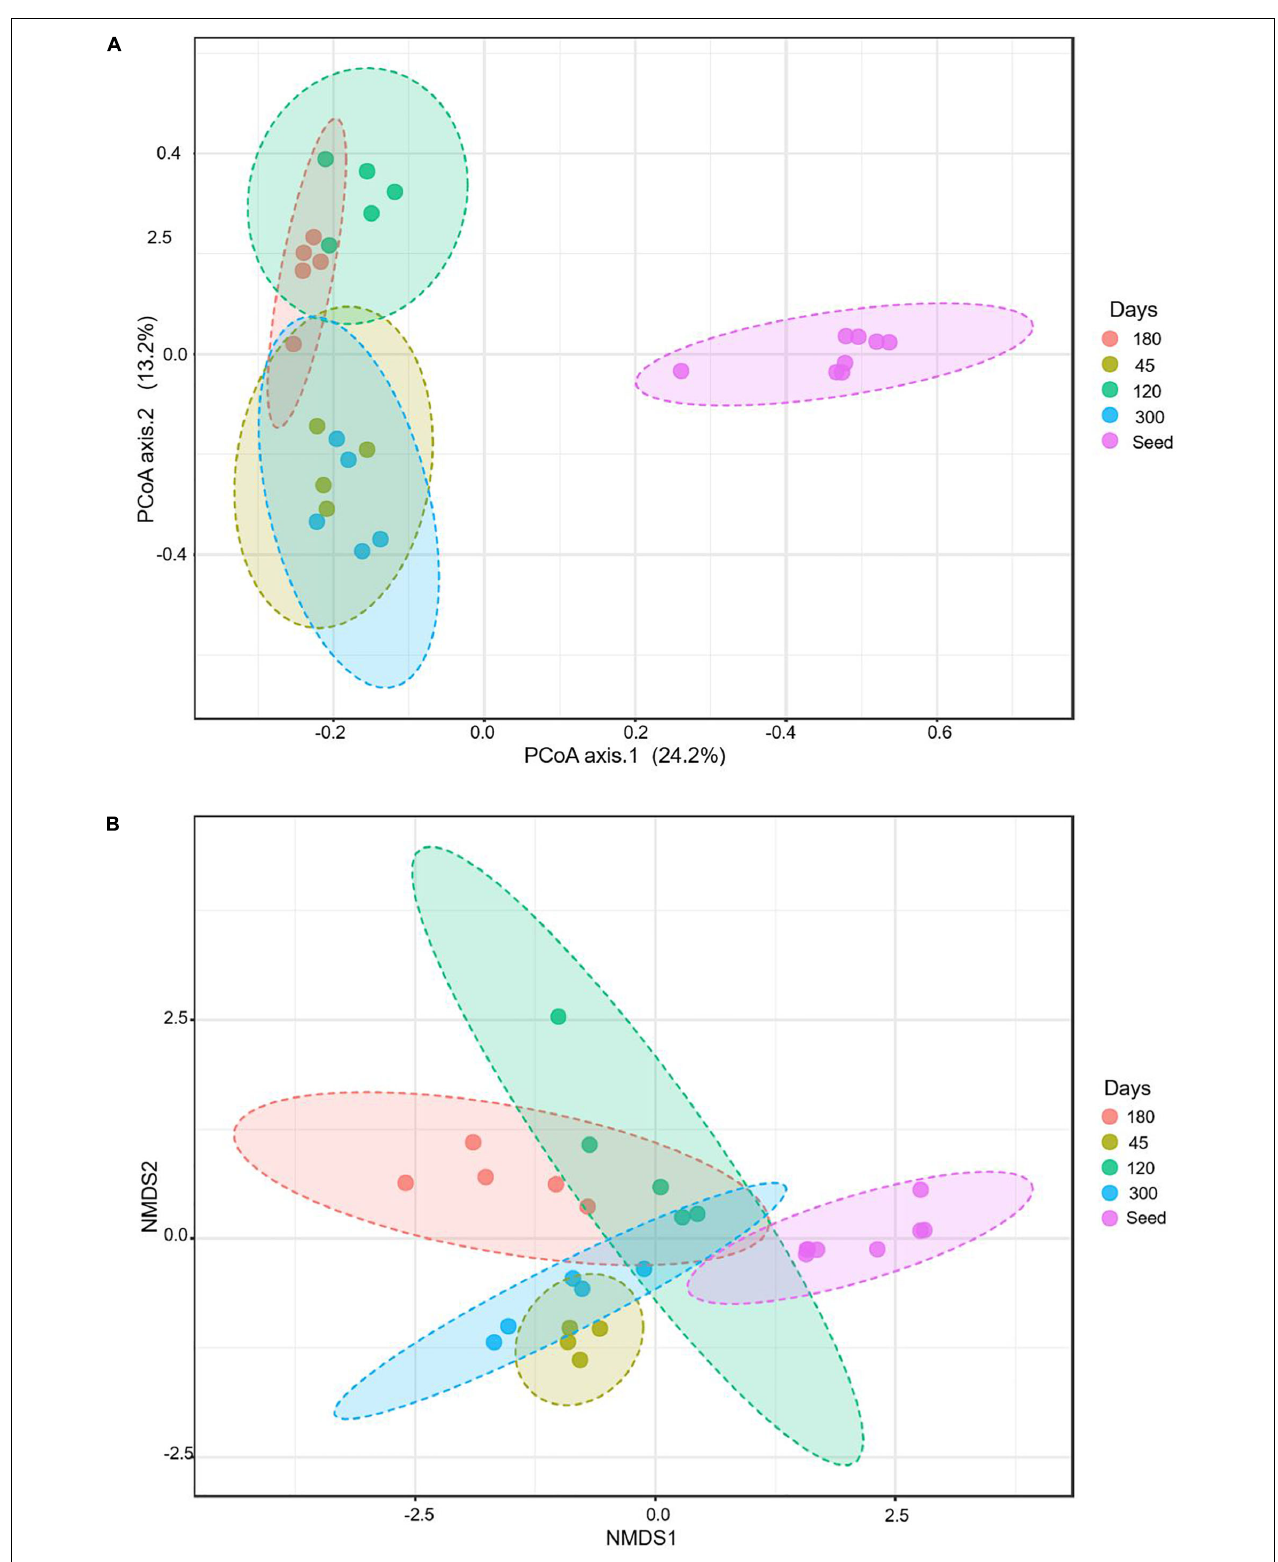
FIGURE 4 | Beta diversity during evolutions of the microbial communities at different time points, based on Bray–Curtis metrics: (A) using principal coordinate analyses (PCoA), and (B) non-metric multidimensional scaling (NMDS).